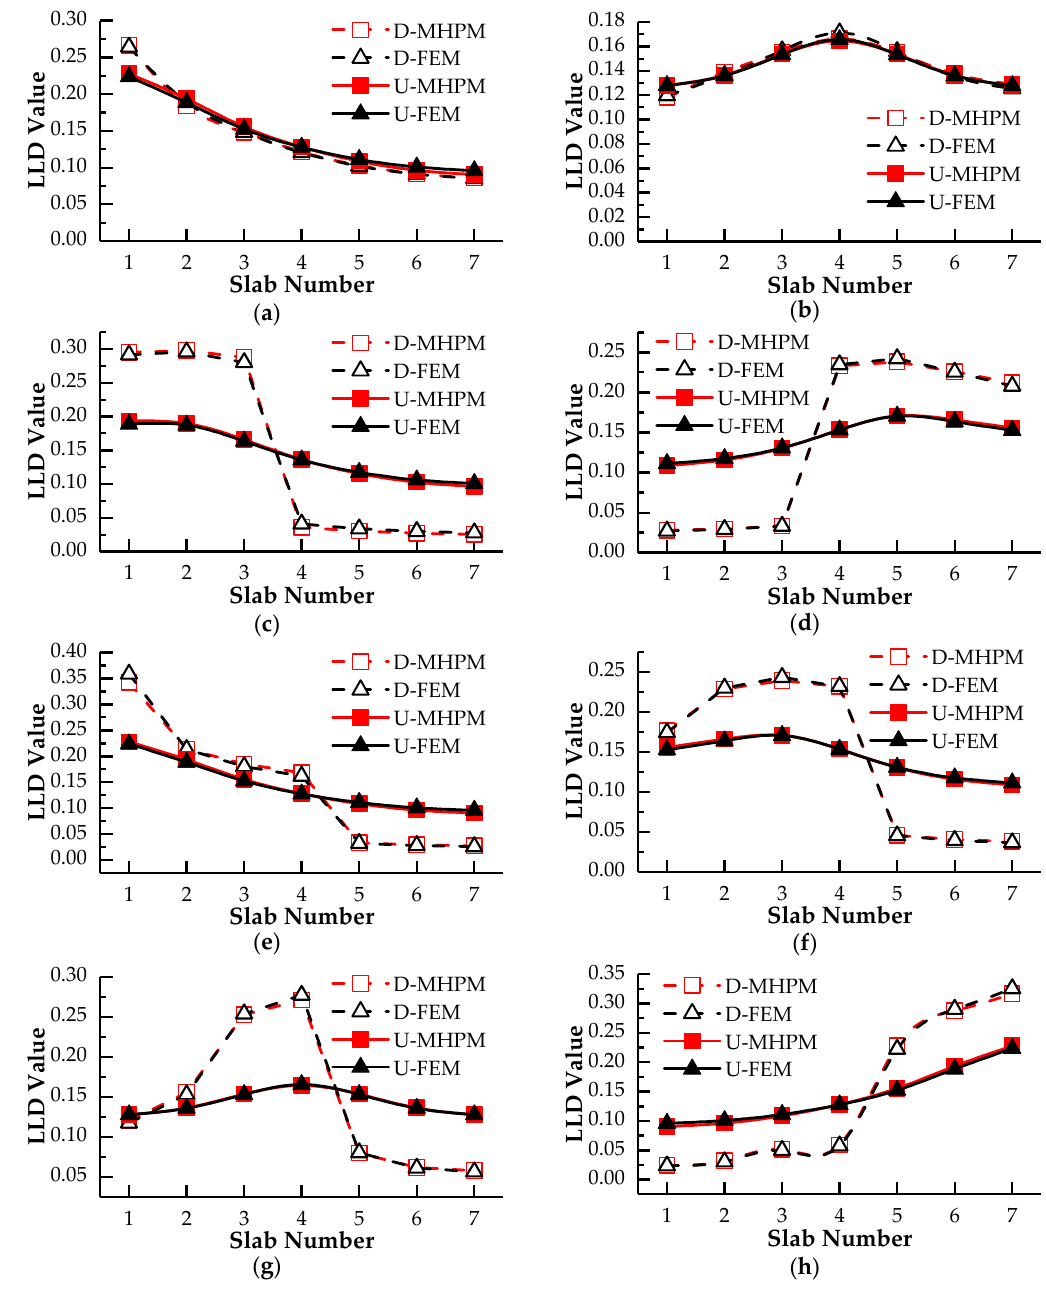
13 of 26 Table 4. Hinge joint damage cases for simply supported bridge with 7 slabs.